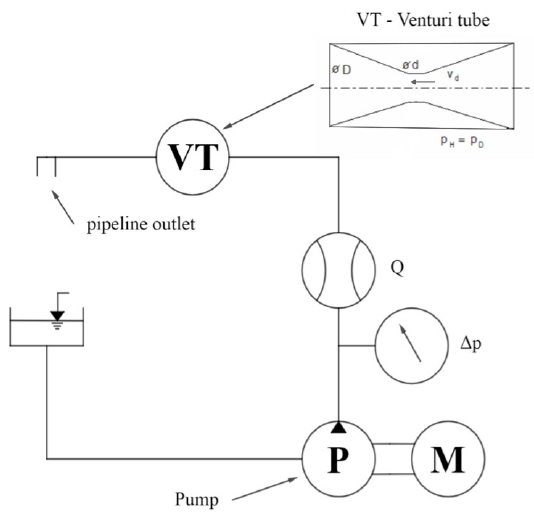
Figure 2. Design of laboratory cavitation equipment.